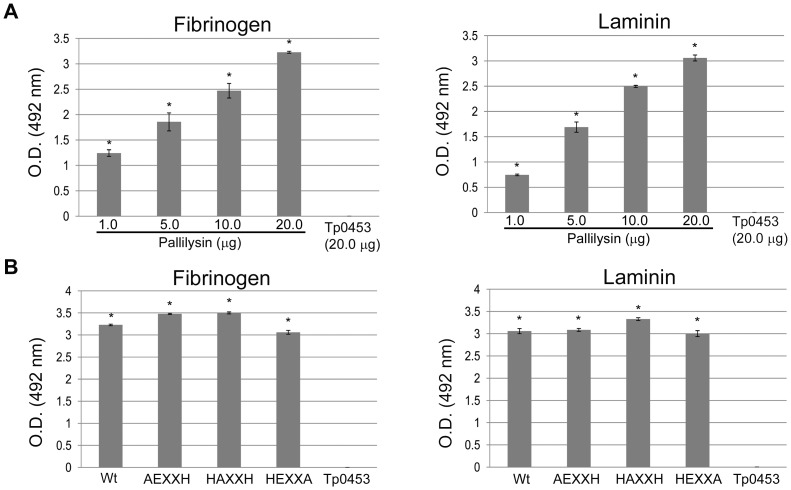
Fibrinogen- and laminin-binding by pallilysin is specific and is not adversely affected by HEXXH mutations.(A) An ELISA-based assay was used to assess the effect of varying concentrations of wild-type pallilysin (0–20 µg per well) on binding to fibrinogen (0.5 µg per well) (left panel) or laminin (0.5 µg per well) (right panel). Recombinant Tp0453 (20 µg) was used as the negative control. (B) The ability of each pallilysin HEXXH mutant, wild-type pallilysin, and the negative control Tp0453 (20 µg each per well) to attach to immobilized human fibrinogen (left panel) or laminin (0.5 µg each per well) (right panel) was assessed using an ELISA-based assay. Average readings from triplicate measurements are presented with bars indicating standard error (SE). The results are representative of two independent experiments. For statistical analyses, attachment to laminin and fibrinogen by wild-type and mutant pallilysin was compared to the attachment of Tp0453 using the Student's two-tailed t test. The three pallilysin HEXXH mutants and all concentrations of wild-type pallilysin (0–20 µg) exhibited statistically significant levels of binding to laminin and fibrinogen compared to the level of binding exhibited by Tp0453 (* indicates p<0.0001).